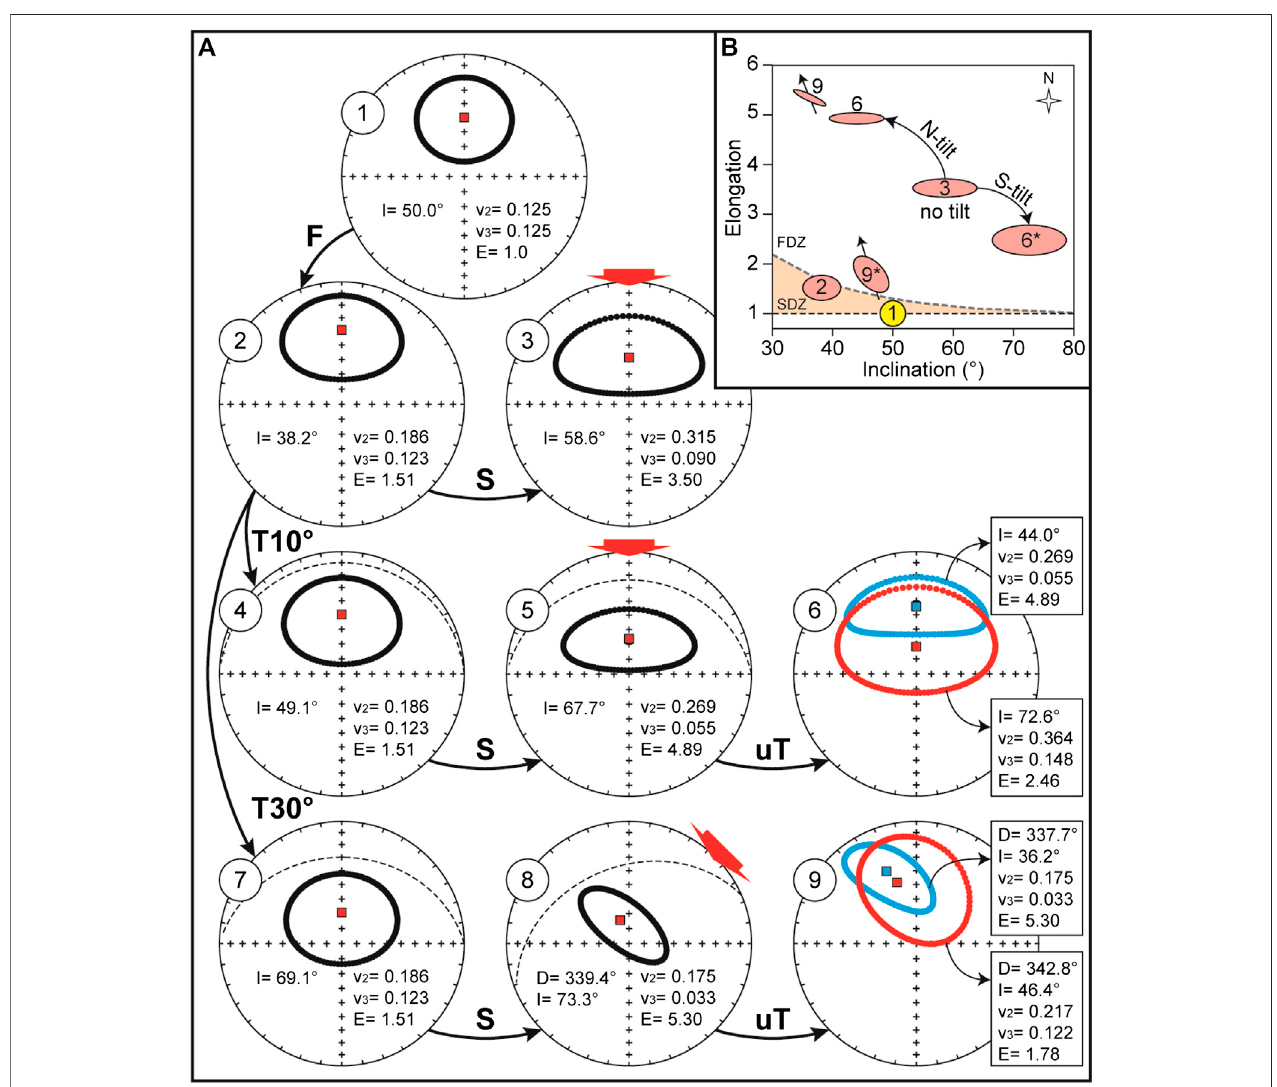
FIGURE 2 | Effect of strain simulation on a purely circular distribution. (A) 1 (cid:1) original distribution; 2 (cid:1) simulated inclination fl attening; 3 (cid:1) effect of a pure compressional shear, with shortening indicated by the red arrow; 4 – 6 (cid:1) effect of combination of pre-compressional strata tilting followed by shortening; while only northward tilting is shown in equal area projections 4 and 5, projection 6 shows the effect, after correcting for the bedding tilt, of both northward (blue) and southward (red) tilting on the same distribution; 7 – 9 (cid:1) same as 4 – 6 but with an initial tilting of 30 ° and simulated shortening directed NE – SW; F (cid:1) fl attening simulation; S (cid:1) shortening; T10 ° and T30 ° (cid:1) 10 ° and 30 ° tilting; uT (cid:1) correction for strained tilt. In all insets: D (cid:1) declination ( ° ); I (cid:1) inclination ( ° ); v 2 and v 3 (cid:1) medium and minimum axes of the distribution matrix (Scheidegger, 1965); E (cid:1) elongation (v 2 /v 3 ). (B) Diagram of elongation (E) vs. inclination (I) of the original circular distribution (1), after inclination fl attening(2),andafterallthelistedstrainsimulations;6and9aretheE/IcouplesforthebluedataplottedinthecorrespondingprojectionsofpanelA,while6*and9*refer to the red data; the shape, size, and orientation of the ellipses re fl ects the variations of the directions distributions as determined by the distribution matrix, while the arrows behind the ellipses are the mean declination of the directions; SDZ and FDZ (cid:1) shallowed and fl awed distribution zone, respectively.